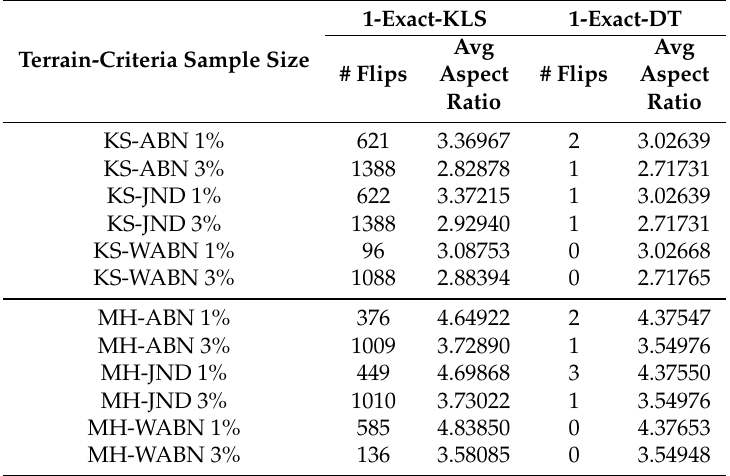
Table 2. Number of flips performed for Kinzel Springs and Moorehead SE, over 1% and 3% sample point sets 1-exact-KLS and 1-exact-DT.